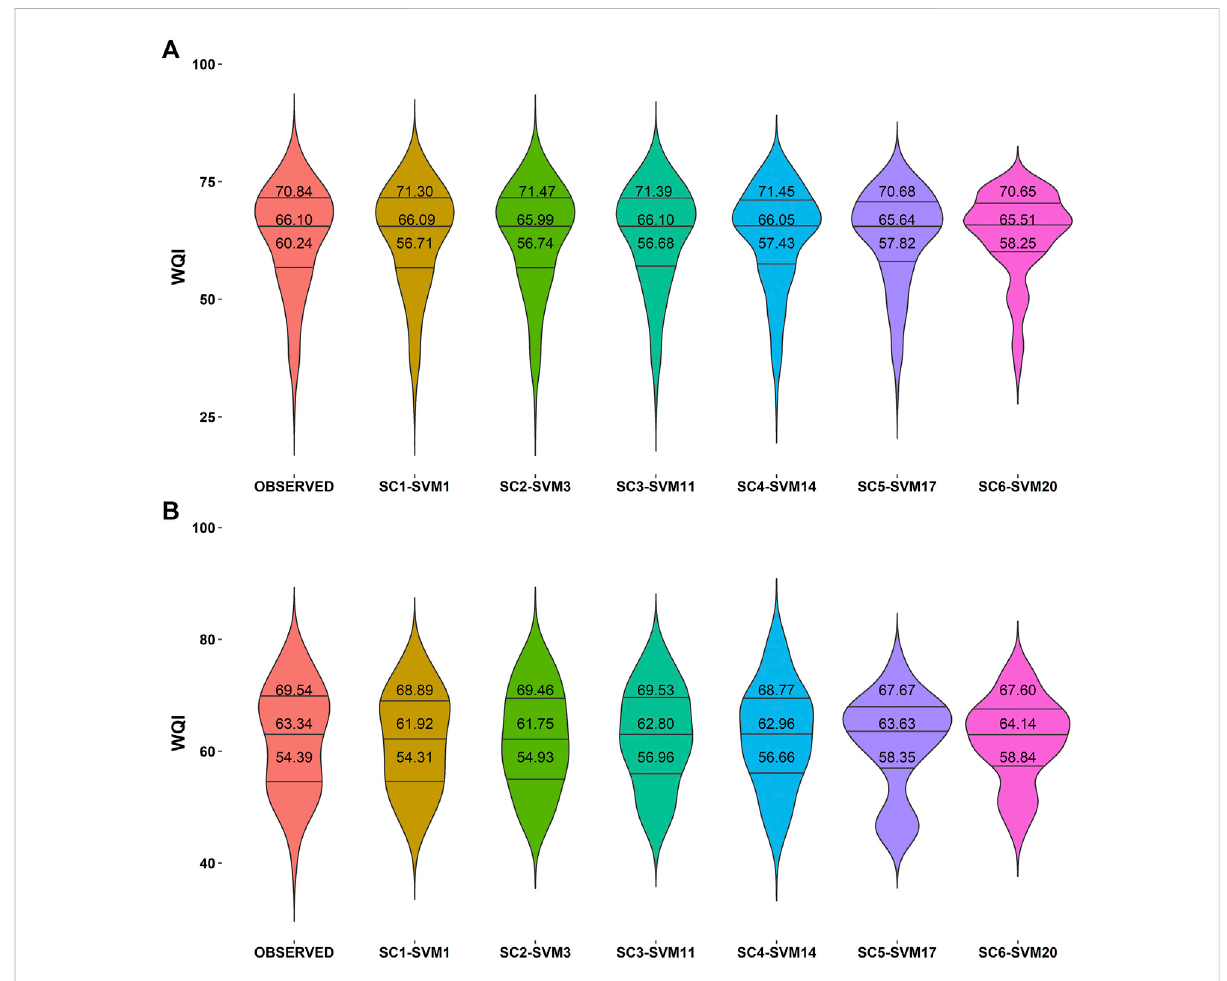
FIGURE 7 Violin plot of observed and predicted WQI values for (A) training phase and (B) testing phase.